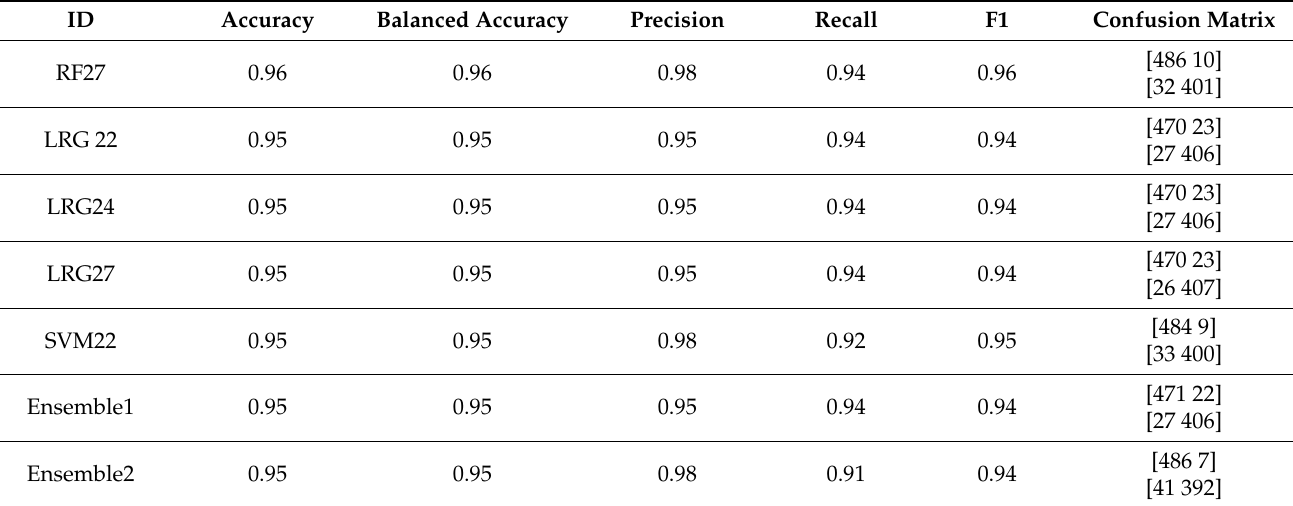
Table 2. Metrics comparison. Single models vs. ensemble using